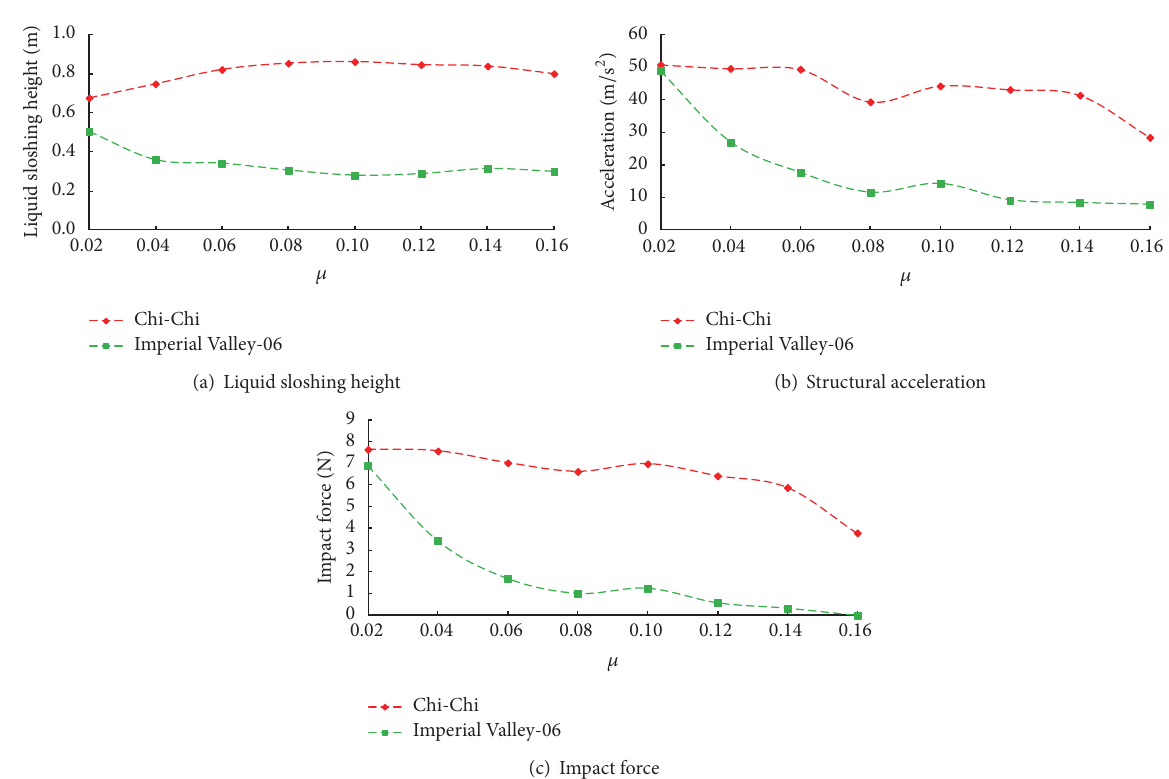
Figure 9: Pounding dynamic responses corresponding to different friction